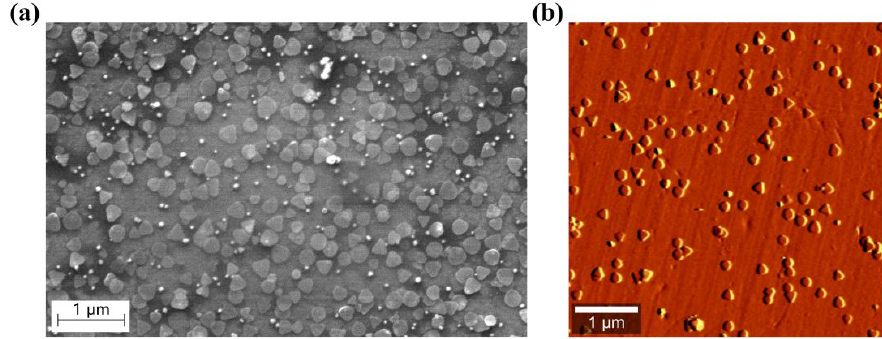
Figure 1. Microscopic images of SNPTs. ( a ) SEM image. ( b ) AFM image.